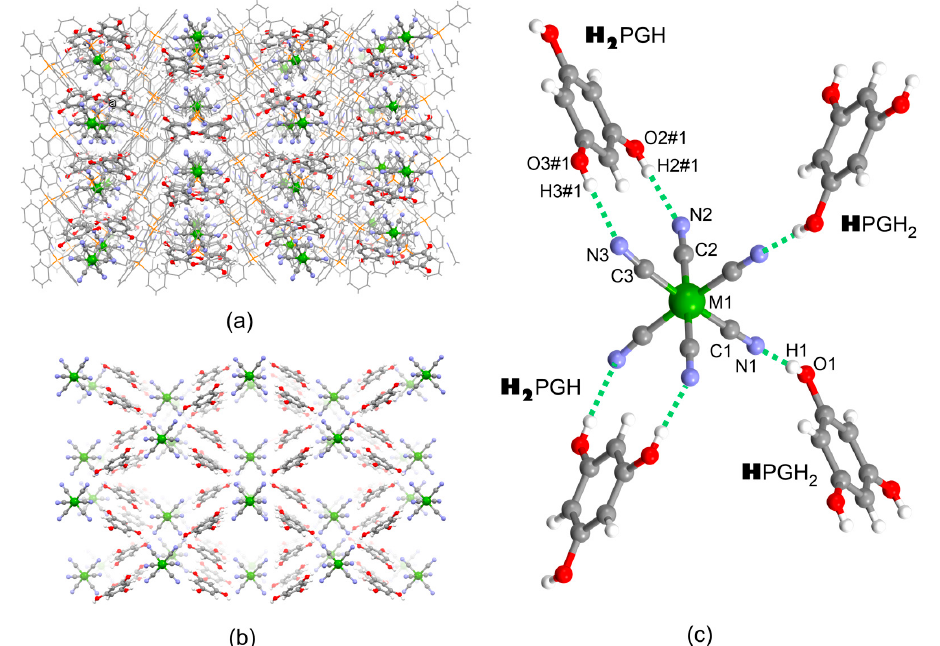
1111 Figure 1. Crystal structure of 1–3: ( a ) hydrogen-bonded {[M(CN) the ab crystallographic plane; ( b ) perpendicular view of hydrogen-bonded {[M(CN) 6 ] 3 − ;(H 3 PG) 2 } layers along c crystallographic direction (PPh 4+ cations and MeCN solvent molecules omitted for clarity); ( c ) supramolecular hydrogen-bonded cis -“bis(chelate)” {[M(CN) 6 ] 3 − ( H 2 PGH) 2 ( H PGH 2 ) 2 } as a part of the hydrogen-bonded single layer (for metric parameters see Table 1). Legend: green—Cr, Fe or Co, grey—C, blue—N, red—O, orange—P, white—H; protons involved in hydrogen bonds with one [M(CN) 6 ] 3 − are indicated in